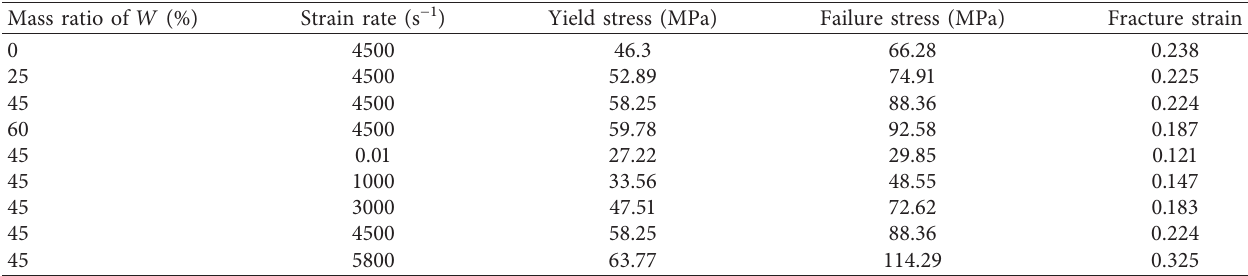
Table 3: Dynamic mechanical properties of the Al/PTFE/W